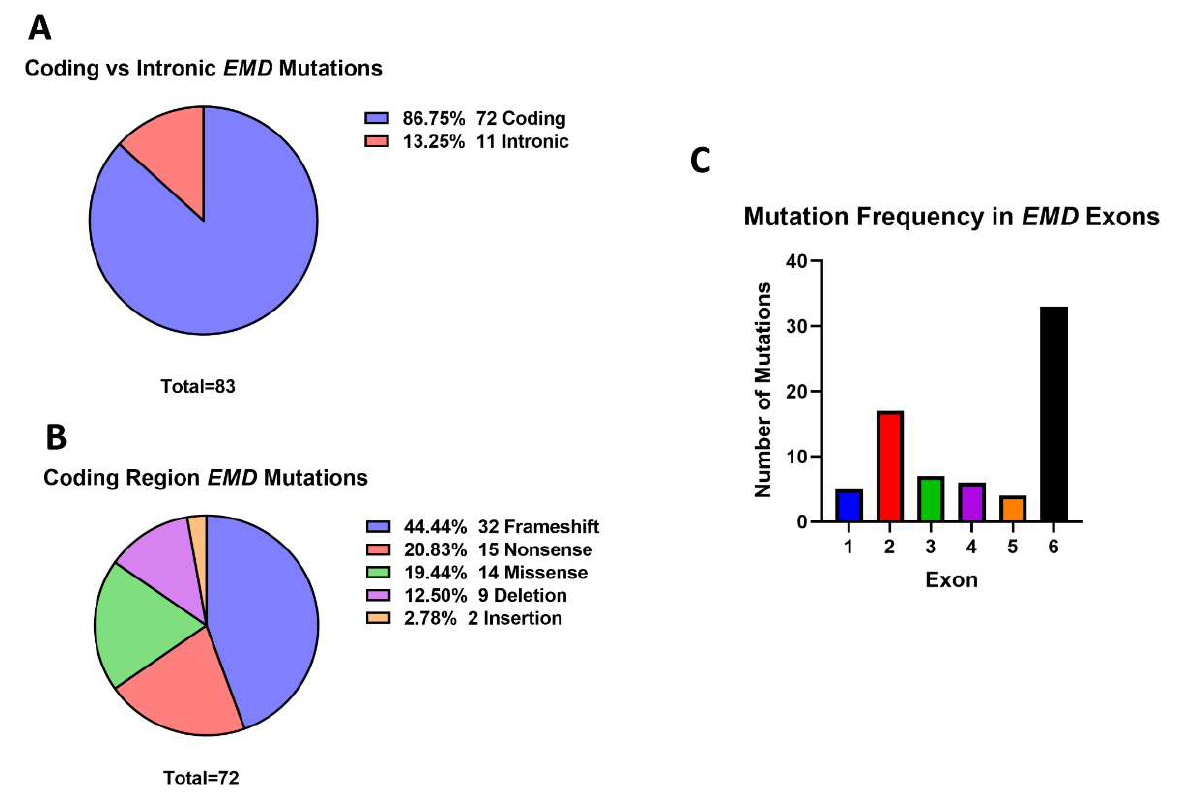
Figure 5. EMD mutations. ( A ) Coding vs. intronic mutations. A total of 83 EMD mutations were identified. 73 (86.75%) were coding region mutations and eleven (13.25%) were intronic variants. ( B ) Coding region mutations. The largest percentage of coding region mutations were frameshift (32, 44.44%), deletion (9, 12.50%) and nonsense (15, 20.83%) variants. Missense mutations (14, 19.44%) also accounted for a considerable proportion of the mutations identified. A couple of insertion (2, 2.78%) mutations were also identified. ( C ) Mutation frequency in EMD exons. Mutations most frequently occurred within exon 6, accounting for 45.21% (33) of total coding region mutations. Exon 2 contained the second highest proportion of mutations (17, 23.29%), followed by exons 3 (7, 9.59%) and 4 (6, 8.22%). Exon 1 and 5 contained the fewest EMD variants (5, 6.85% and 4, 5.48%, respectively). Created with GraphPad